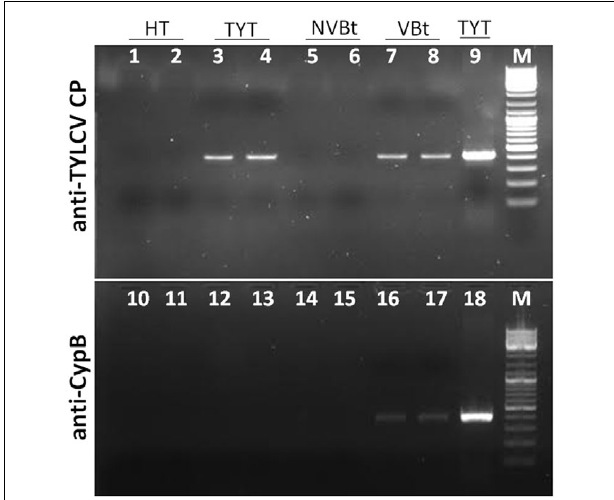
FIGURE 4 | Immunocapture-PCR assay to detect CypB-TYLCV CP interaction in viruliferous whiteflies (VBt). Lanes 1–8 and 10–17 represents microtiter plates coated with an anti-TYLCV CP and anti-CypB specific antibodies, respectively, and a PCR was performed on the caught virus-CypB complexes. Lanes 1, 2, 10, and 11 are leaf extract from HT, lanes 3, 4, 12, and 13 are leaf extract from TYLCV-infected tomato (TYT). Lanes 5, 6, 14, and 15 are extracts of NVBt, and lanes 7, 8, 16, and 17 are extracts of VBt. Lane 9 and 18 are genomic extracted from TYT (PCR positive control). TYLCV V61-C473 ( Table 1 ) primers were used to amplify the virus bind to the anti-TYLCV CP and anti-CypB